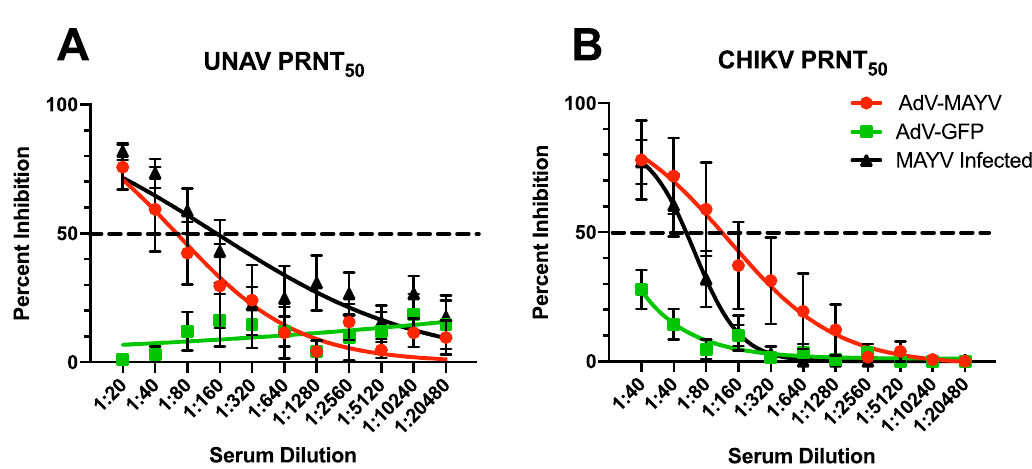
Fig 9. AdV-MAYV Elicits Cross Neutralizing Antibodies Against Una and Chikungunya Viruses. In order to determine whether the AdV-MAYV elicited cross-protection against related alphaviruses, PRNT 50 assays were performed on serum from WT C57BL/6N mice vaccinated with AdV-MAYV, AdV-GFP vaccinated, and compared to serum from mice infected with MAYV. Shown are the average PRNT 50 values calculated for each group (n = 5). PRNT50 assays for (A) Una virus and (B) CHIKV indicate cross-species neutralization is elicited in serum from mice vaccinated with AdV-MAYV as well as mice infected with MAYV but not for serum collected from AdV-GFP vaccinated controls. Curves were calculated using a variable slope non-linear regression analysis. Error bars representing SEM from 5 biological